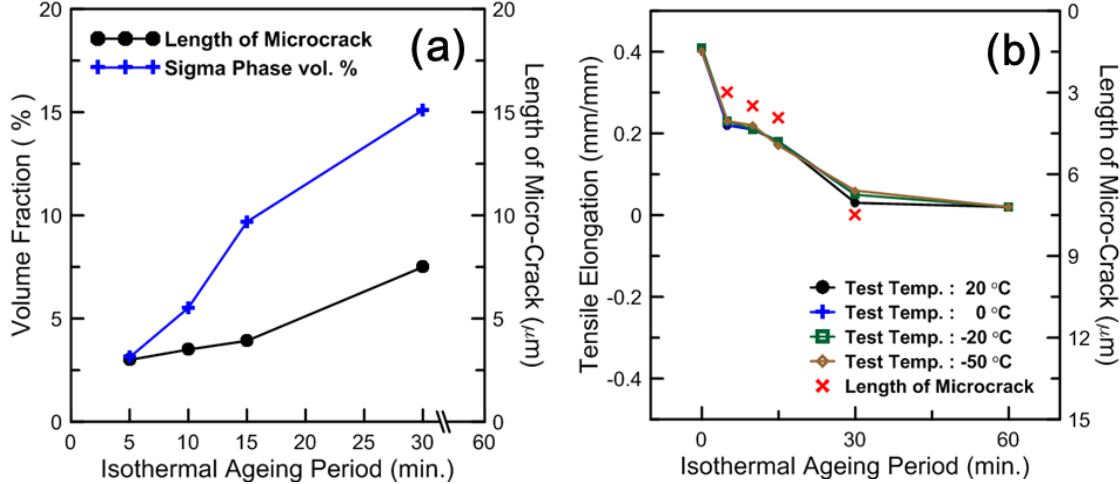
Figure 11. Comparison of the relationship between length of microcrack and ( a ) volume fraction of σ phase and ( b ) tensile elongation according to various test